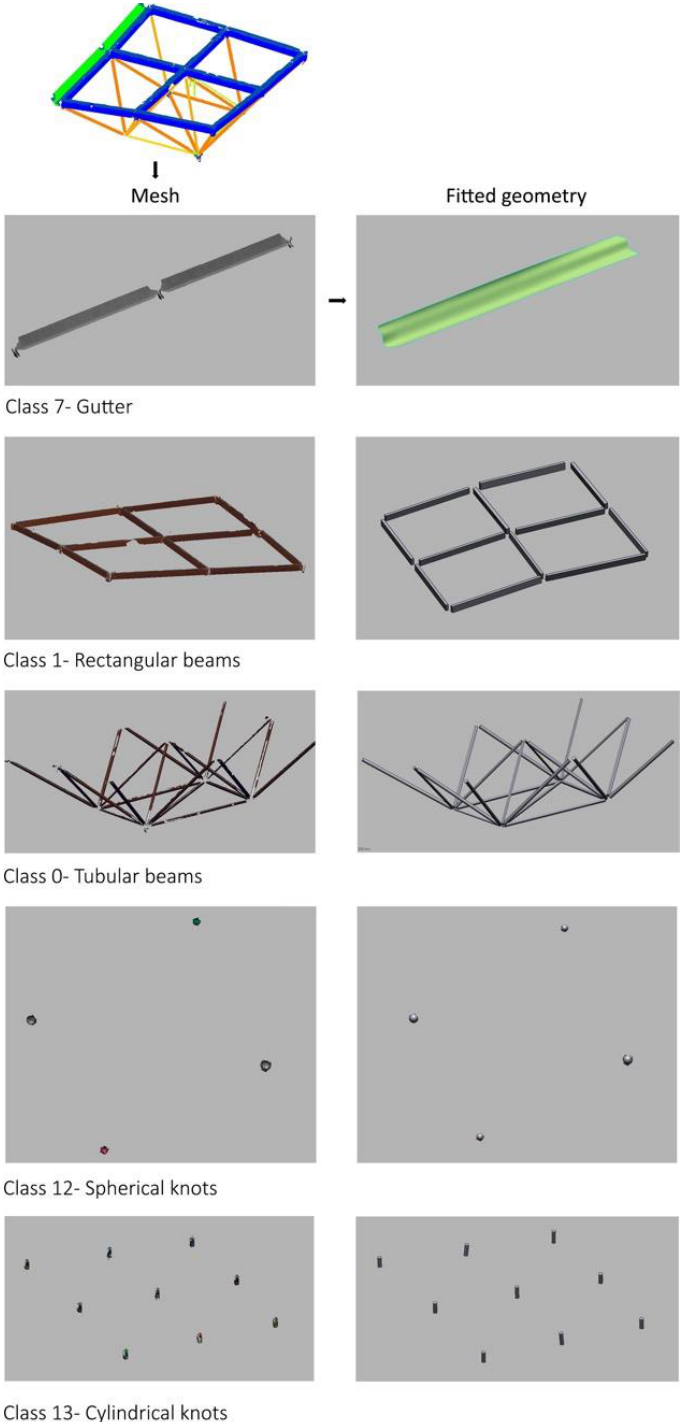
Figure A3. Mesh reconstruction (to the left) and related fitted geometry (to the right) for different classes of the mesh grid.